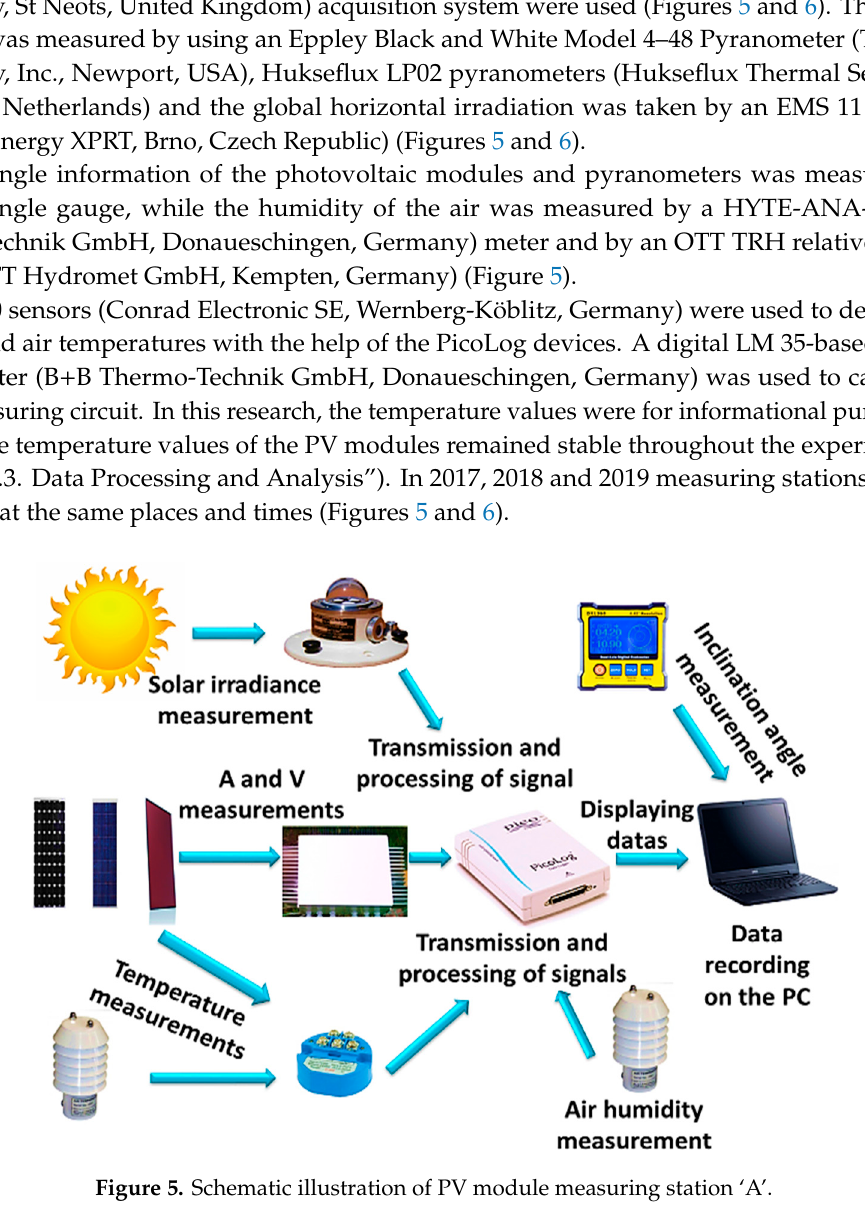
Figure 6. Schematic illustration of PV module measuring station ‘B’. For positioning the photovoltaic modules two linear actuators were used. By a handheld remote control, it was possible to carry out a set of attempts, which were suitable for both horizontal and/or vertical control. The accurate adjustment to the sun was checked by the visible focus point (FP) of the CPV solar module (Figure 7) because at this position the rays of the sun are ideally positioned, perpendicularly to the photovoltaic modules. The measurements at the FP position were used as a reference in order to obtain the power loss as a function of the solar tracking uncertainty angle. Thus, it was possible to measure the technology-specific performance losses in the case of inaccurate sun tracking compared to the ideal position. With inadequate dual tracking devices, it is difficult to provide appropriate measurement conditions, which may lead to erroneous evaluation of the data.